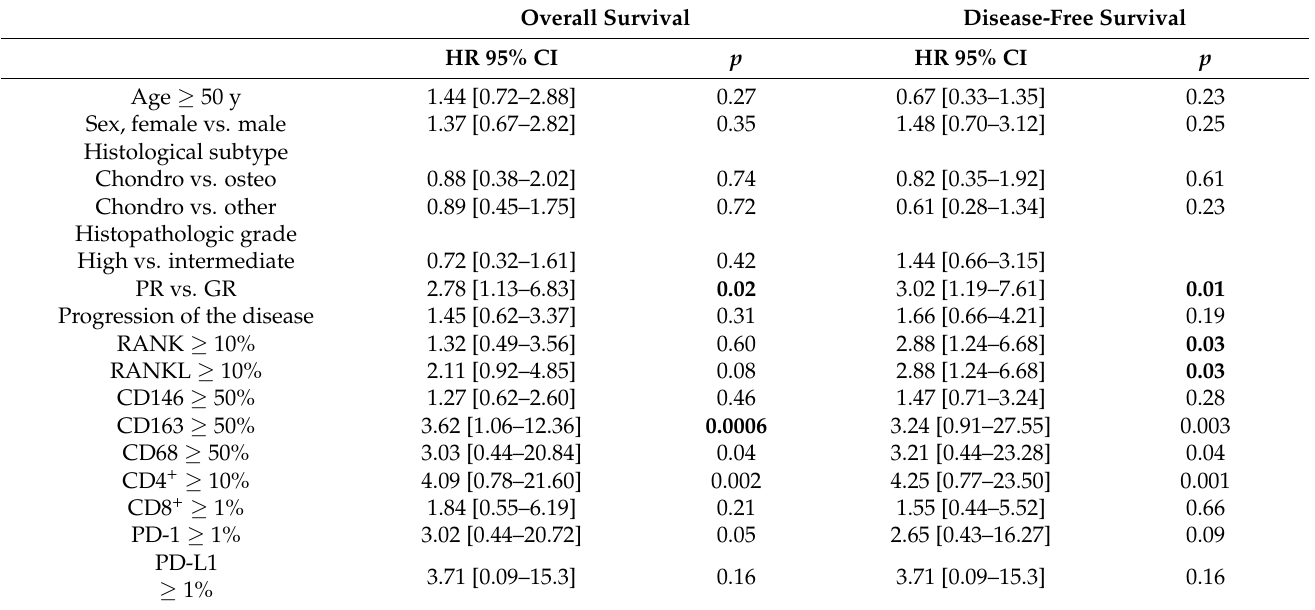
Table 3. Univariate analysis of overall survival and disease-free survival. HR, hazard ratio; CI, confidence interval; PR, poor responder; GR, good